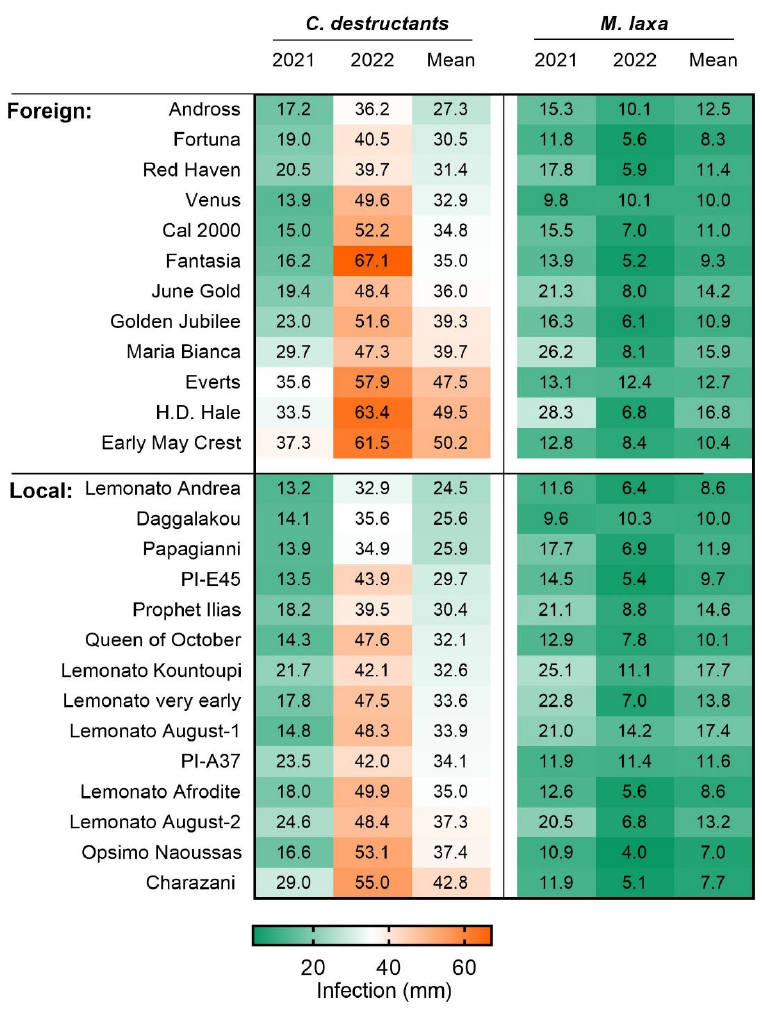
Figure 3. Length of lesion (mm) in one-year-old shoots after inoculation with C. destructants and M. laxa in different peach local and foreign cultivars evaluated in 2021 and 2022. LSD C. destructants = 8; LSD M. laxa = 5.3.